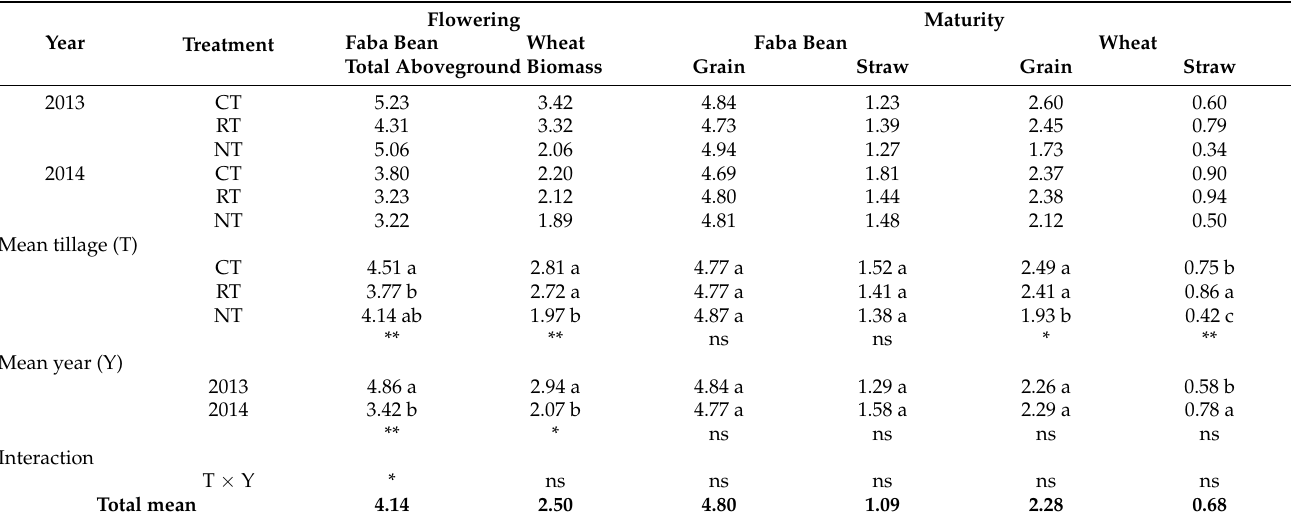
Table 3. Elemental N concentration (% on the dry weight) in faba bean and wheat crop aboveground biomass and grain at two crop growth stages with respect to tillage system and study year.